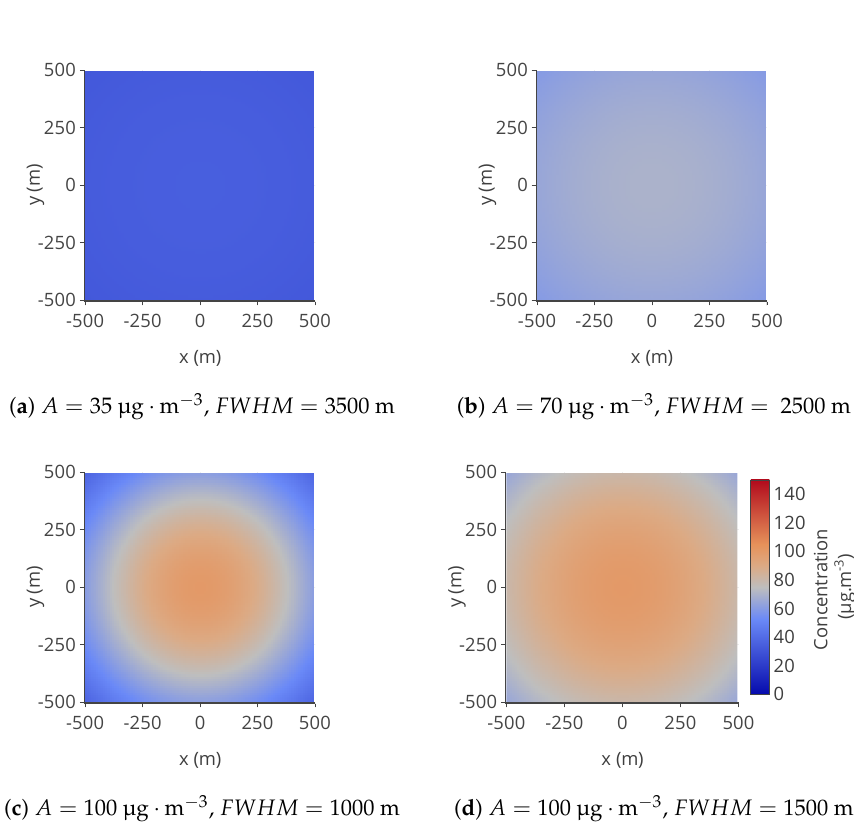
x 2 + y 2 (cid:0) − ( (cid:1) 2ln ( 2 )) 2 FWHM 2